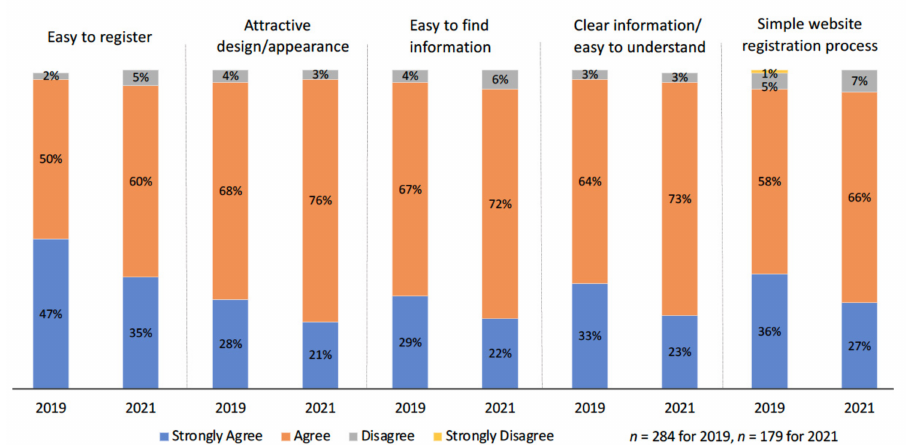
Figure 3. Experience with registration processes 1. Note: 2021 survey respondents ( n = 179) were newly registered since 2019 survey.